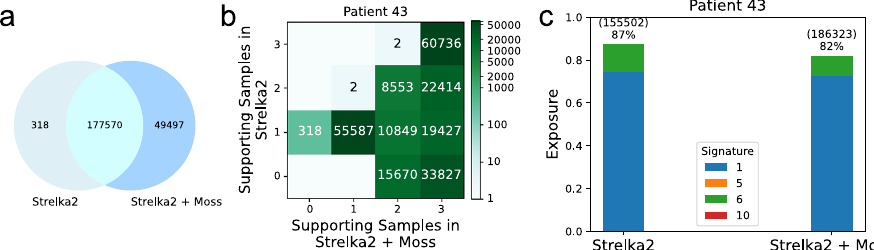
Fig. 5 Moss recovers high-quality somatic variants missed by Strelka2 in a colorectal cancer (CRC) dataset 32 . a Venn diagram comparing the call set of Strelka2 when run in isolation and when run in conjunction with Moss. Moss identi fi es 49,497 new variants while retaining almost all variants identi fi ed by Strelka2. b The number of supporting samples by Moss ( x -axis) and the single-sample caller Strelka2 ( y -axis) for each variant, showing that Moss increases the number of supporting samples for 23% of variants (52,690 variants) identi fi ed by Strelka2, increasing the number of common SNVs (single- nucleotide variants) that are present in at least two samples (Supplementary Fig. 12). c Exposure to mutational signatures of colorectal tumor for the different methods (each signature is represented with a unique color). The identi fi ed signatures remain the